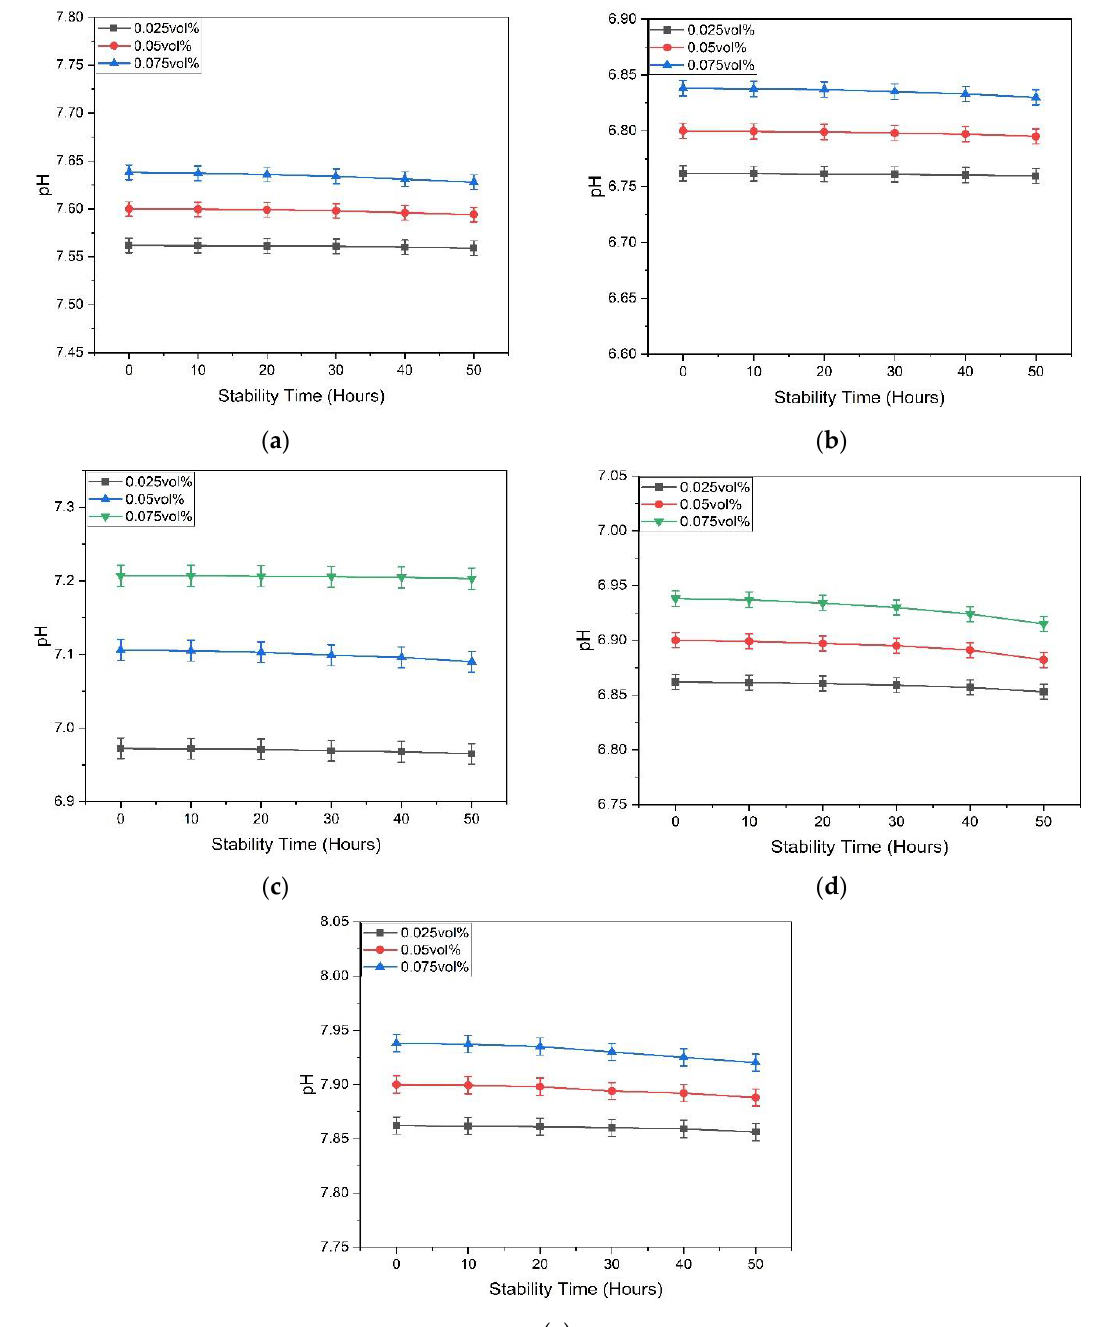
Figure 5. Variation in maximum pH ( a ) MWCNT – H 2 O ( b ) MWCNT – EG ( c ) Al 2 O 3 – H 2 O ( d ) Al 2 O 3 – EG ( e ) MgO –